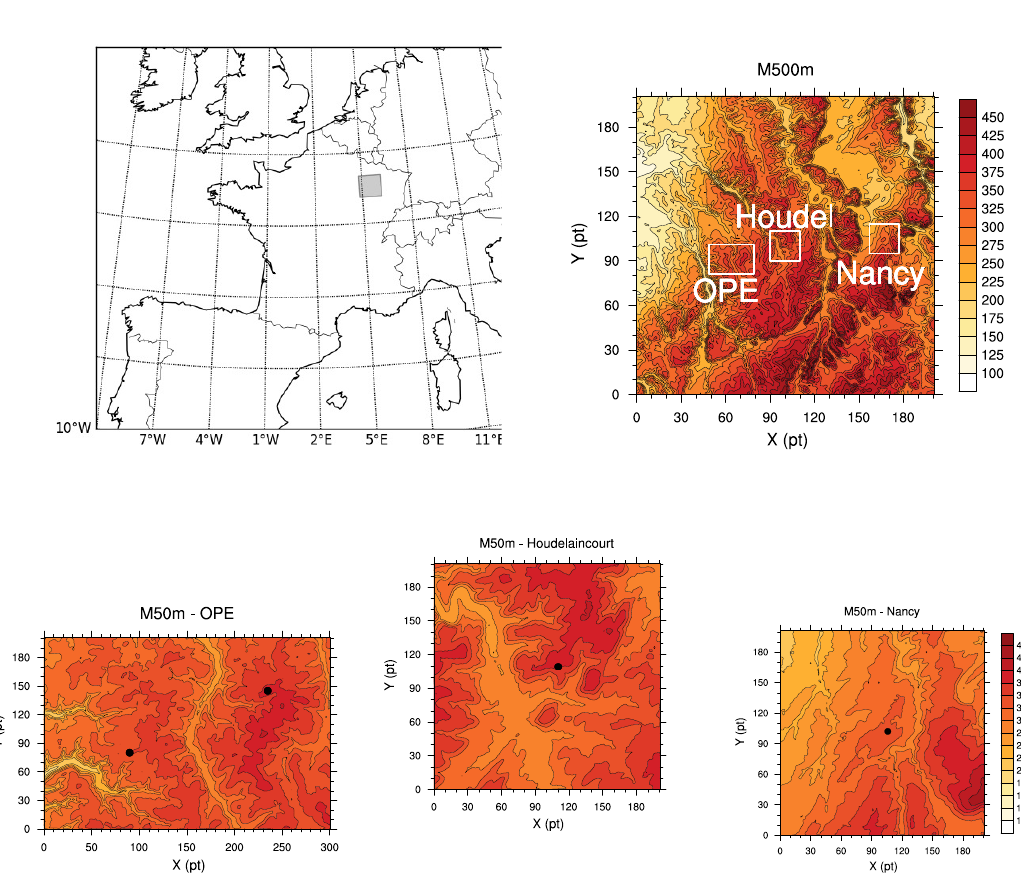
Figure 1. Geographical location of the simulation domains. The grey area corresponds to the M500m model. Topographical feature of the M500m and three M50m models, elevation in meters; the black dots correspond to the locations of